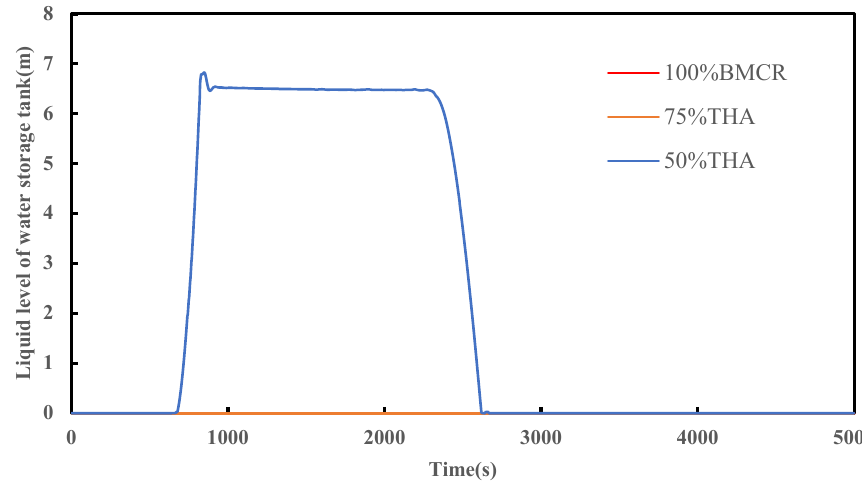
Figure 8. Response of liquid level of water storage during MFT at different conditions.